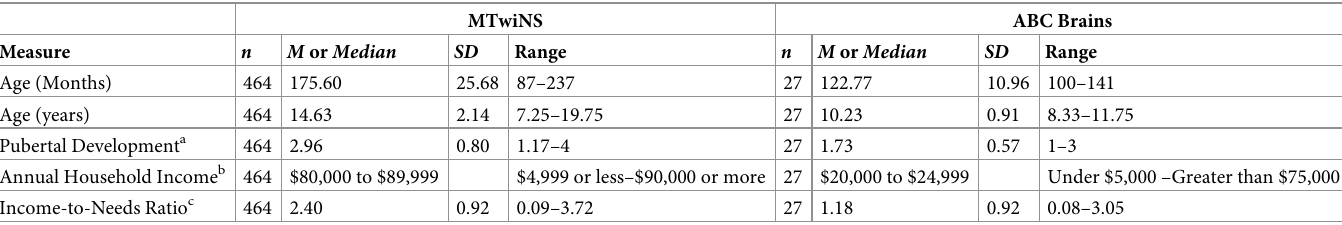
Table 1. Demographic characteristics of the MTwiNS and ABC Brains